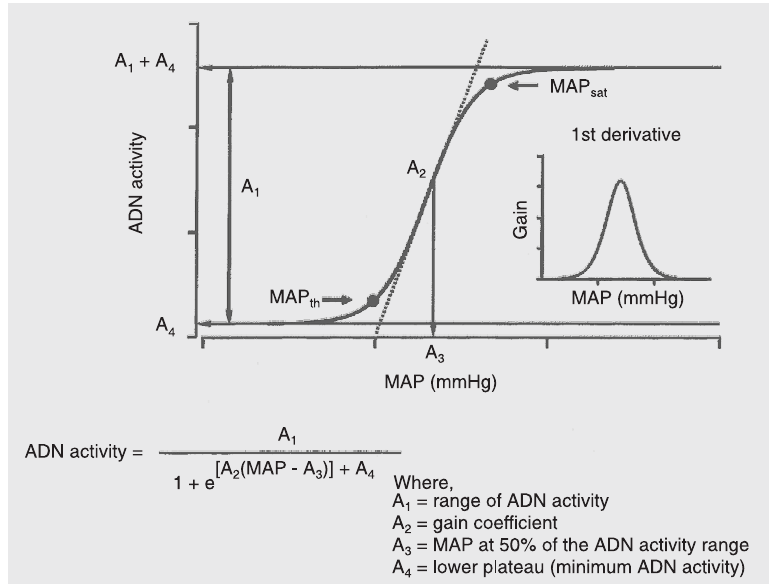
Figure 1. Theoretical plot of mean arterial pressure (MAP) vs aortic depressor nerve (ADN) activity curve using 4-parameter logistic sigmoidal regression: A 1 , range; A 2 , slope coefficient; A 3 , MAP at 50% of ADN activity range; A 4 , lower plateau; A 1 + A 4 , upper plateau. MAP th = MAP threshold for baroreceptor activation; MAP sat = MAP corresponding to saturation of the discharges (continuous discharges). Inset , 1st derivative of the slope (gain) of the